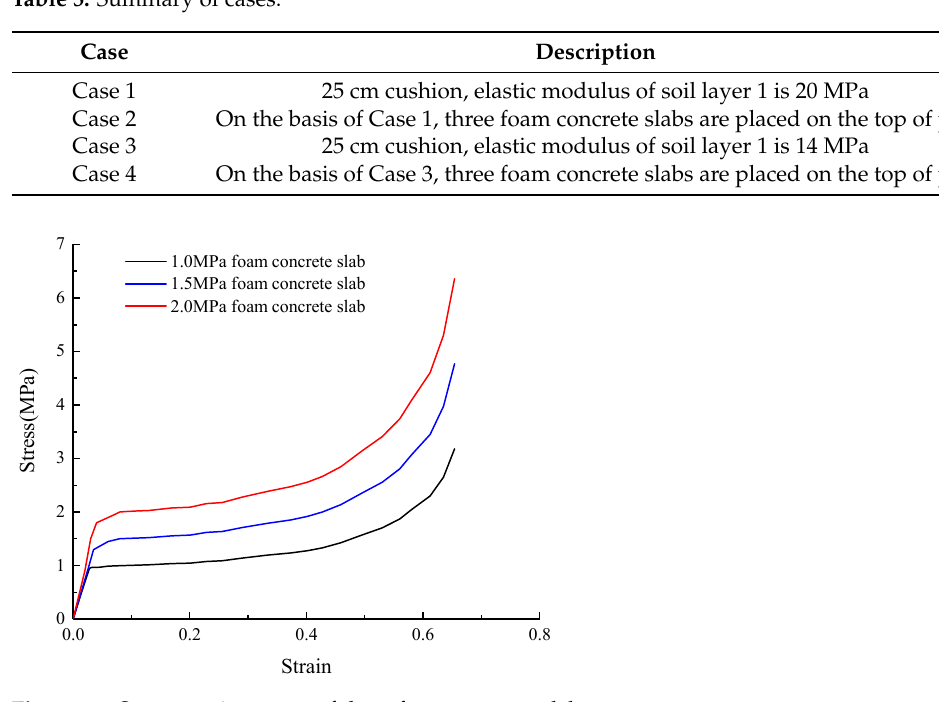
Table 5. Summary of cases.